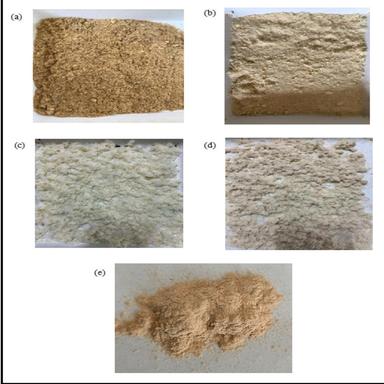
Bamboo fibers at different stages of treatments: (a) untreated BF (b) alkali treated BF (c) bleached BF and (d) alkali treated after bleaching and (e) nanocellulose.